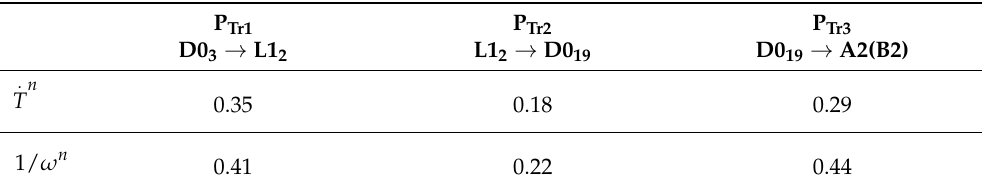
Table 4. Values for ‘ n ’ in eqs vibrations.